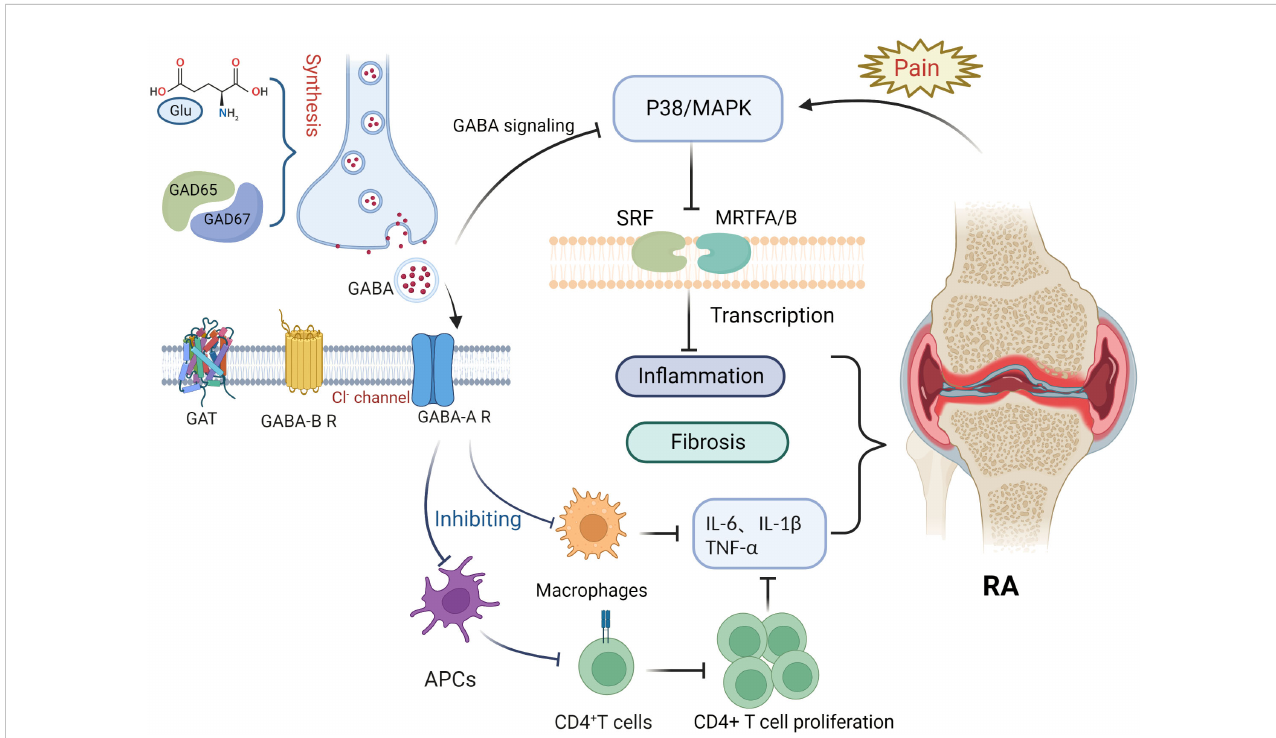
FIGURE 1 Potential role of the gamma-aminobutyric acid (GABA)ergic system in rheumatoid arthritis. Glutamate interacts with glutamate decarboxylase (GAD65 and GAD67) to produce gamma-aminobutyric acid (GABA). Binding of GABA to GABA-A receptors inhibits macrophage activation and decreases the release of in fl ammatory factors such as IL-6, IL-1 b , and TNF- a . Antigen presentation by antigen-presenting cells, however, is impaired, inhibiting CD4 + T cell proliferation and differentiation and reducing the expression of in fl ammatory factors such as IL-6, IL-1 b , and TNF- a . Pain signaling activates the P38/ MAPK pathway, whereas GABA binding to GABA-A receptors inhibits P38/MAPK. The P38/MAPK signaling pathway contributes to in fl ammation and is involved in the activation of myocardin-related transcription factor A (MRTFA), myocardin-related transcription factor B (MRTFB), and serum response factor (SRF) that played key roles in fi broblast